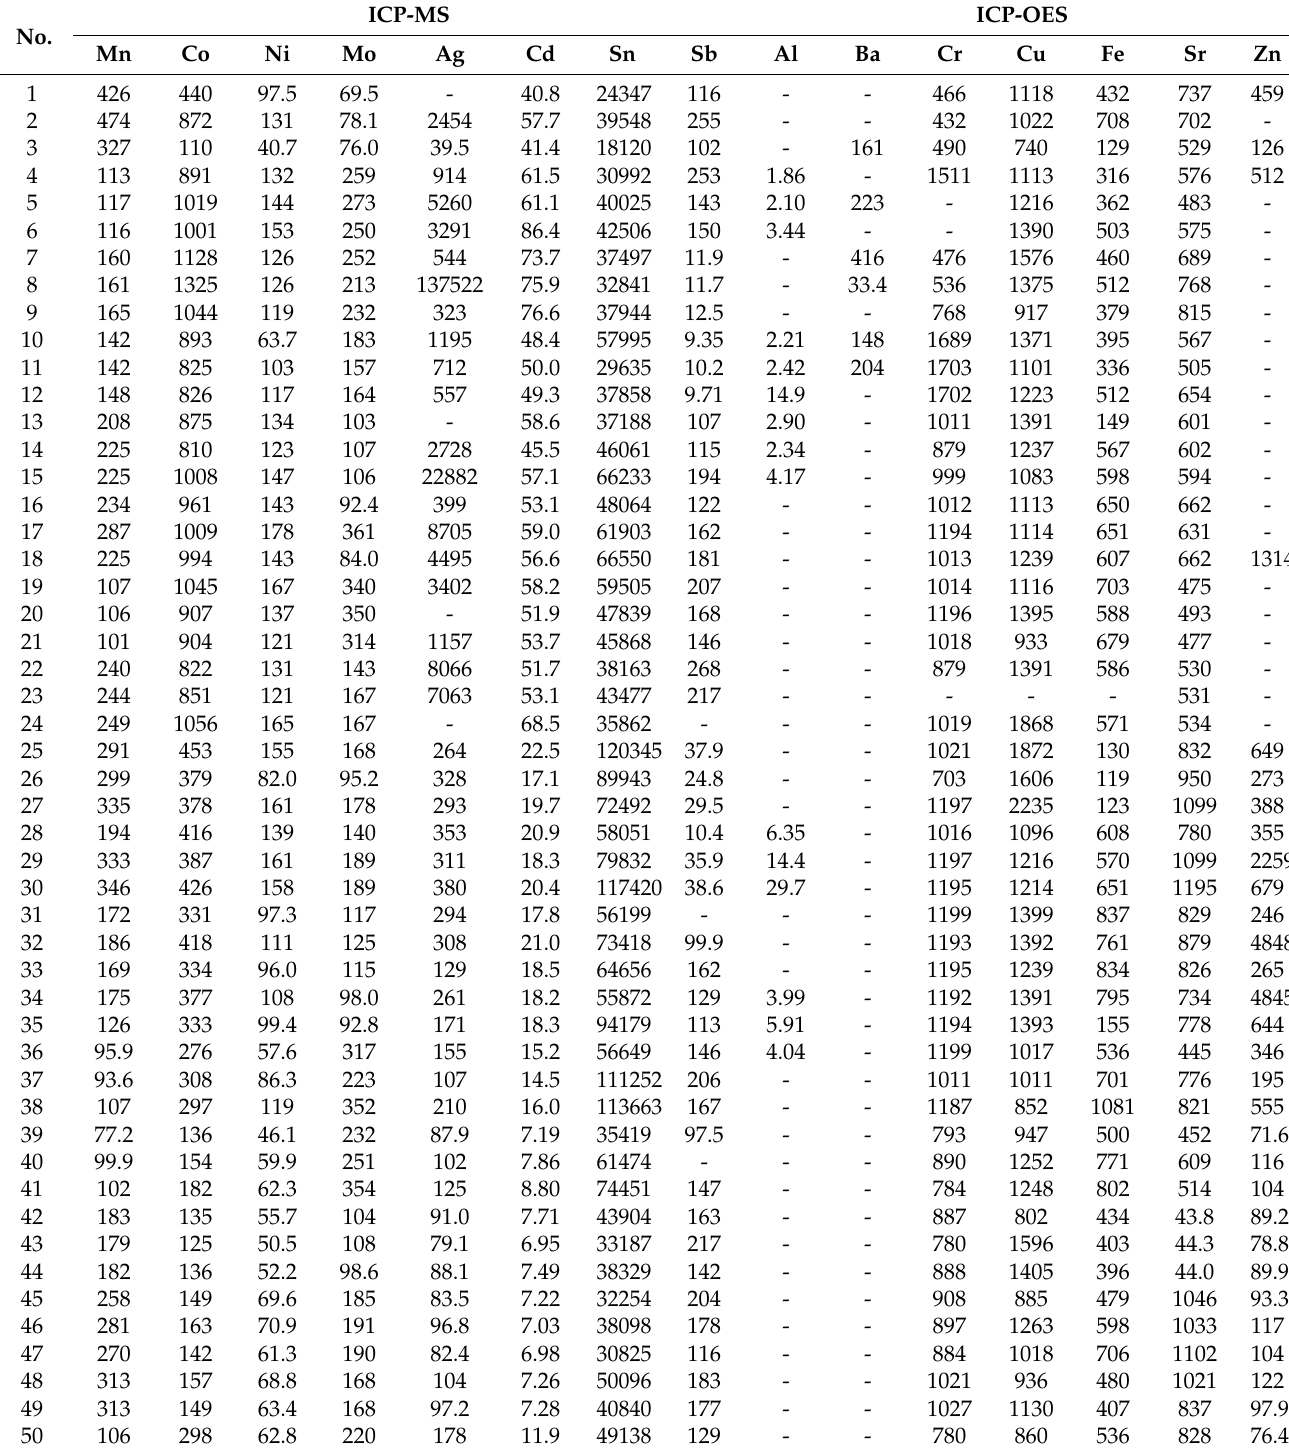
Table 9. Risk assessment of chosen elements for beer